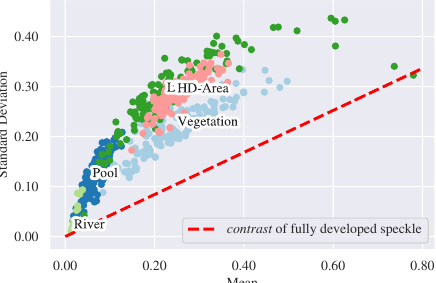
Figure 4. The discriminative capability of the mean and standard deviation. Five classes of TerraSAR-X images are represented by the mean and standard deviation which are estimated according to Equation (9). Although distinctive cluster centers are formed by River , Pool , and Vegetation , there are still apparent confusions between the high-density (HD) area and the low-density (LD) area.